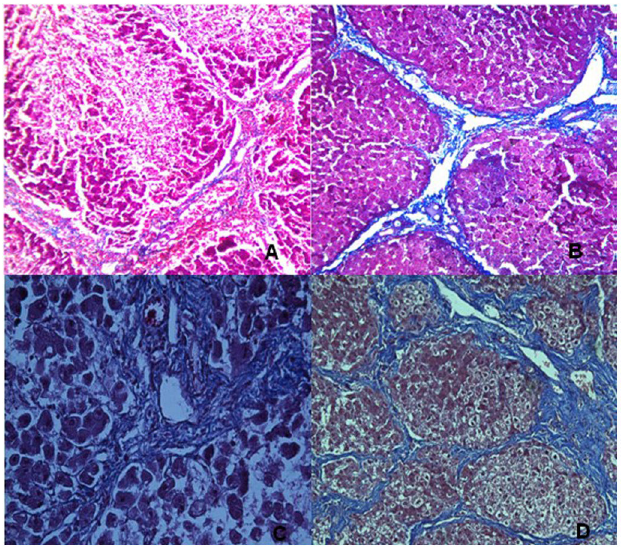
Figure 2. Photomicrographs (original magnification, ×400; Masson’s trichrome stains) of histologic sections from liver biopsy specimens. The figure shows the progression of fibrosis in minipigs: stage 1, portal fibrous expansion (A); stage 2, thin fibrous septa emanating from portal triads (B); stage 3, fibrous septa bridging portal triads and central veins (C); and stage 4, cirrhosis (D).